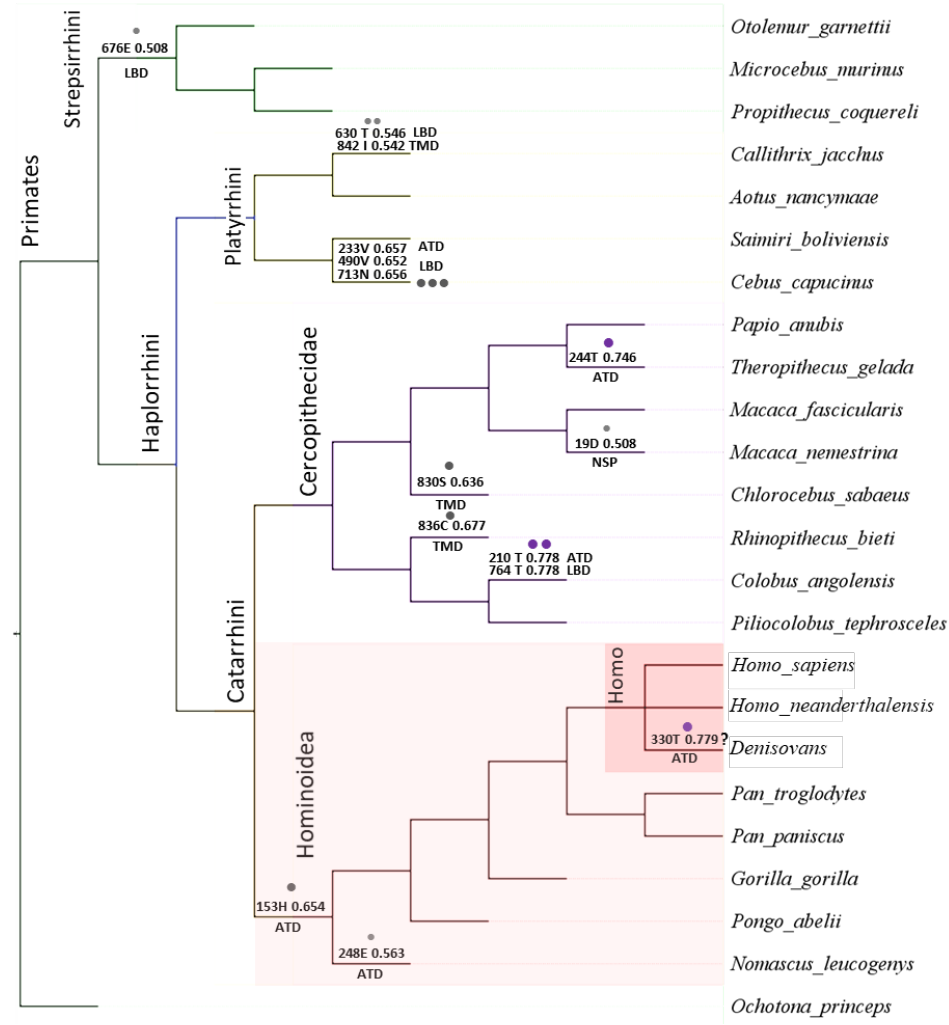
Figure 4. Phylogenetic tree for the primate dataset of GRID2 gene. Putative sites determined in model A1 using Bayes Empirical Bayes (BEB) method are indicated in branches by dots; amino acid site position with a BEB probability value and protein domain are specified. “?”—The presence of this variant is not unambiguous and could be a result of ancient DNA hydrolytic deamination.